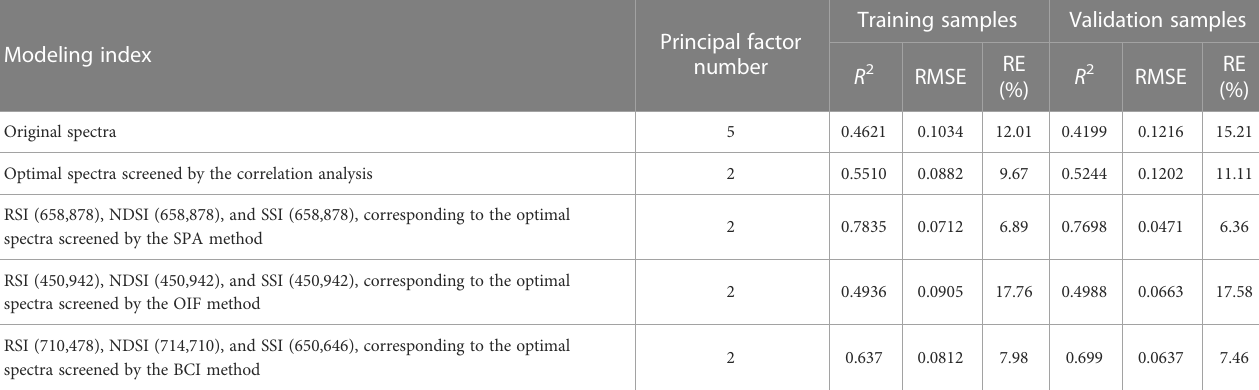
TABLE 4 Precision evaluation of CGI estimation based on PLSR